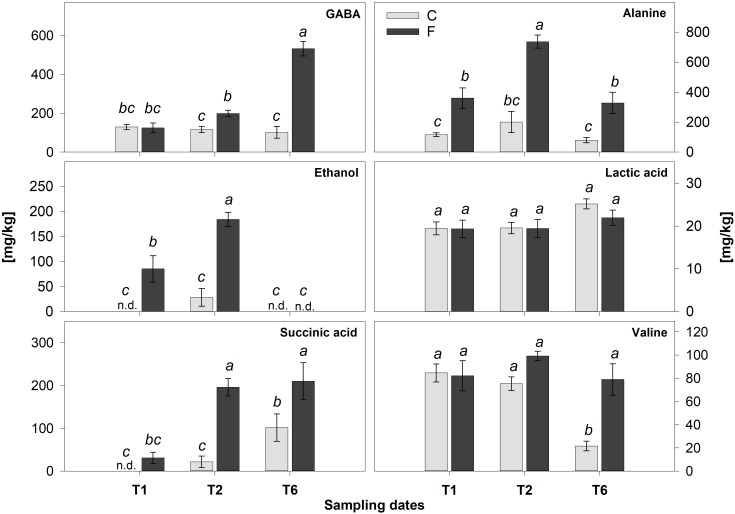
Quantification of the main metabolites identified by 1H-NMR in flooded (F) and control (C) samples at T1, T2, and T6. Values are mean ± SE (n = 5). Significant differences (Duncan’s test, p < 0.05) are marked by different letters, n.d., not detectable.